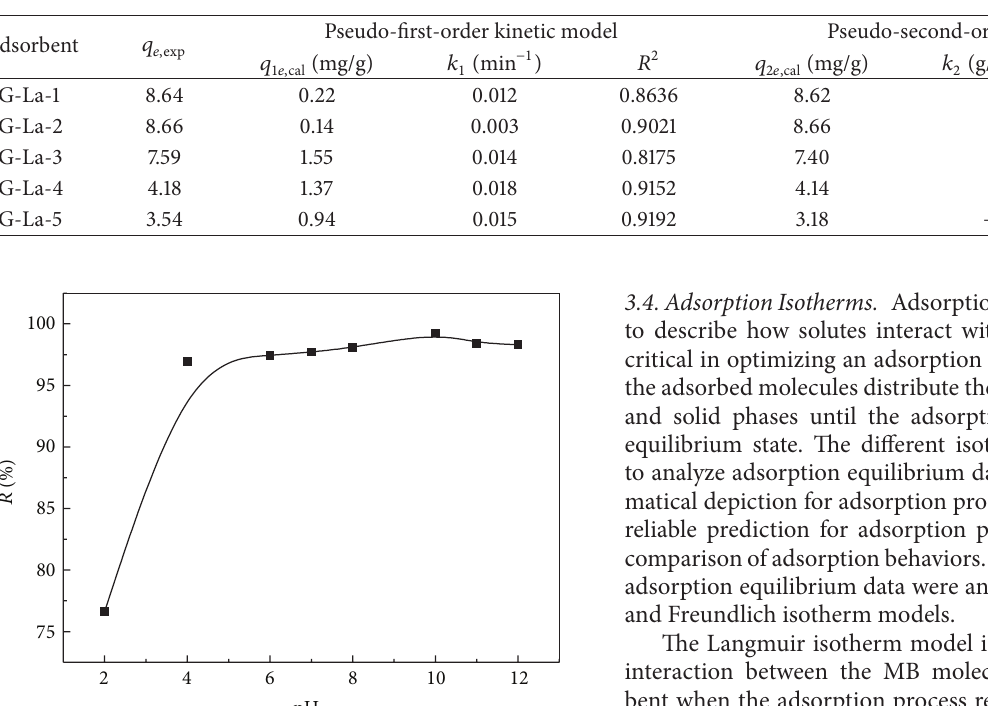
Table 3: Comparison of kinetics parameters of MB onto BG-La.